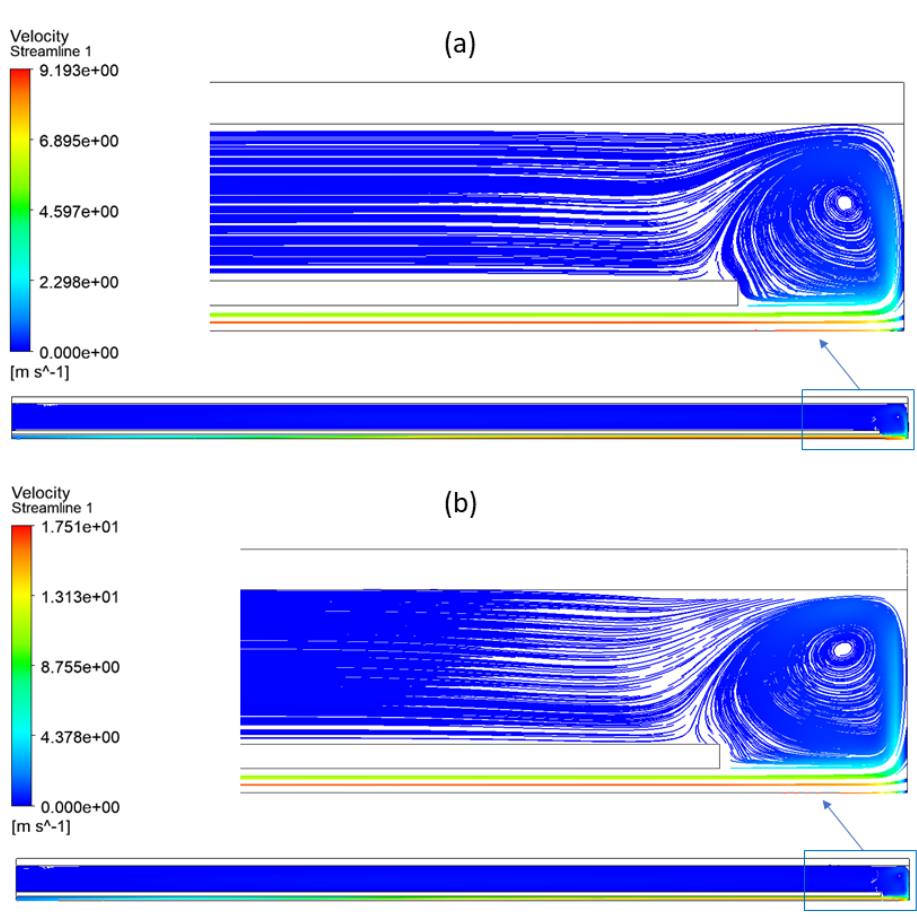
Figure 11. Velocity streamlines in the reactor with a zoom at the bottom part: ( a ) case 1 and ( b ) case